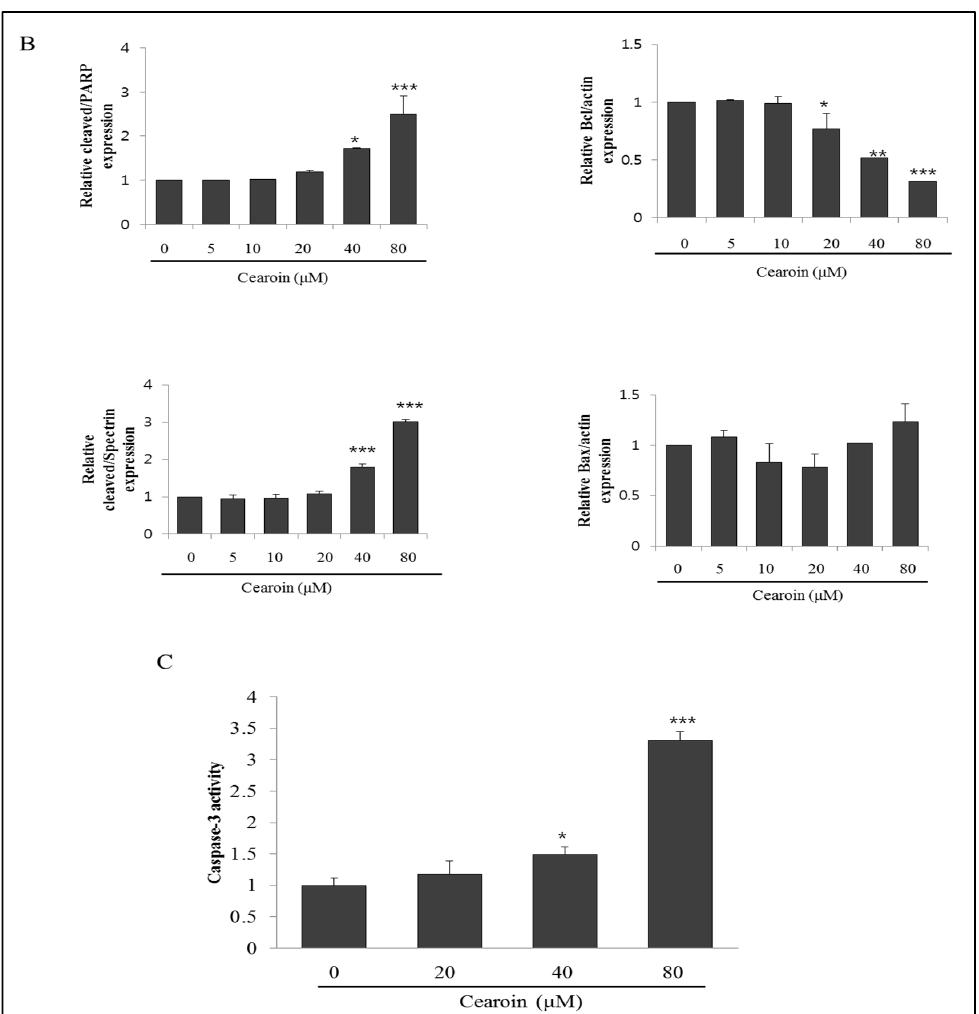
Figure 3. Cearoin induces apoptotic cell death in SH-SY5Y neuroblastoma cells. ( A ) SH-SY5Y neuroblastoma cells were treated with cearoin in various concentrations (0, 5, 10, 20, 40, or 80 μ M) and incubated for 12 h. Then, the cells were lysed, and the proteins levels of PARP, α -spectrin, Bax, Bcl-2 and actin were determined by Western blot analysis. The blots shown are representative of three independent experiments. Actin was used as a loading control; ( B ) quantification by densitometry. Each bar represents the mean fold alterations above the control (±SD) ( n = 3); ( C ) SH-SY5Y neuroblastoma cells were treated with cearoin in various concentrations (0, 20, 40, or 80 μ M) for 3 h and the caspase-3 activity was measured using caspase-3 activity assay kit. Each bar represents the mean fold alterations above the control (±SD) ( n = 3). Differences were considered statistically significant at * p < 0.05, ** p < 0.01 and *** p < 0.001 as compared with the control.